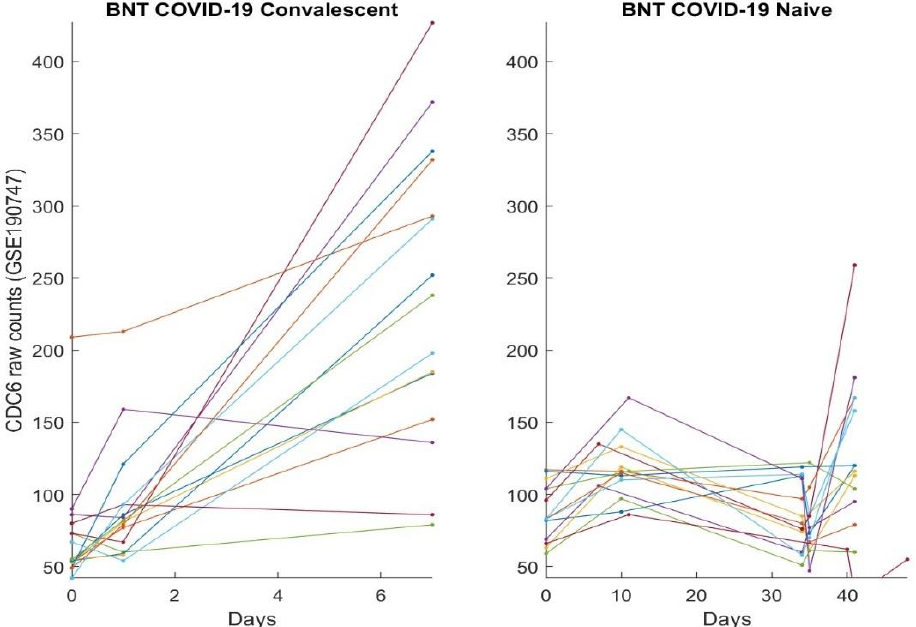
Figure 3. CDC6 expression responses to BNT162b2 vaccines: The left panel is for COVID-19-recovered octogenarians; the right panel is for COVID-19-naïve individuals. Each color line corresponds to one patient’s records.